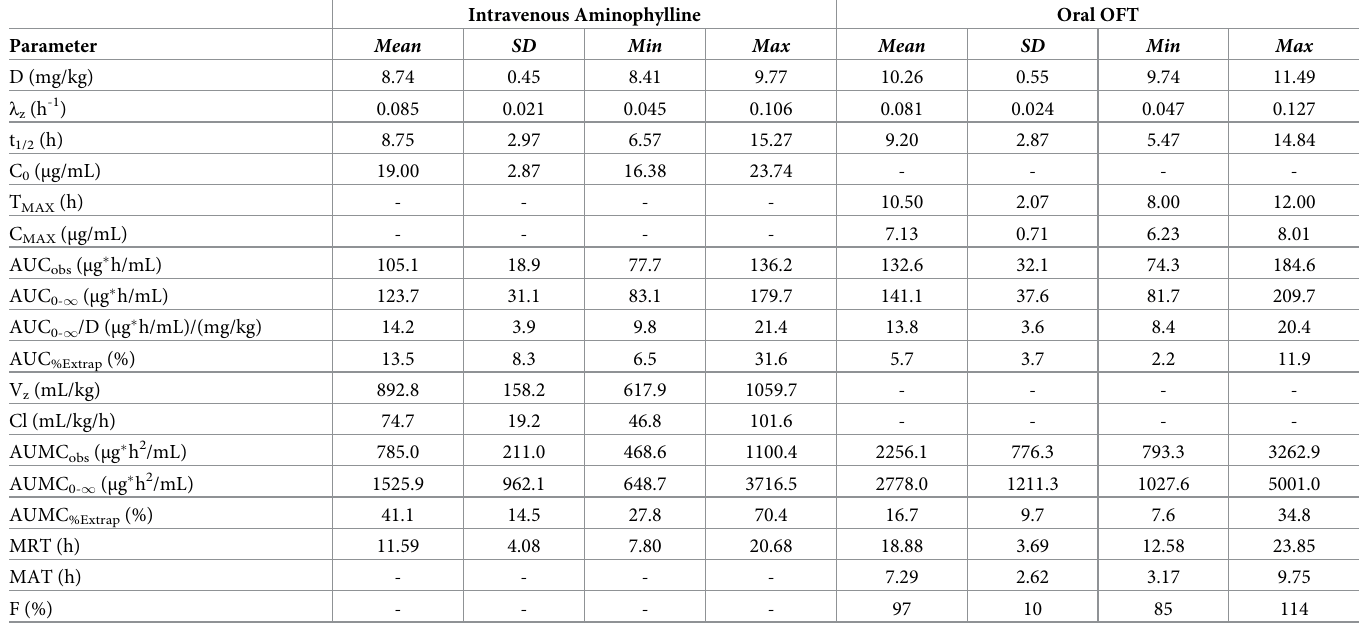
Table 1. Pharmacokinetic parameter summary statistics for non-compartmental analysis of single dose intravenous aminophylline and oral OFT in